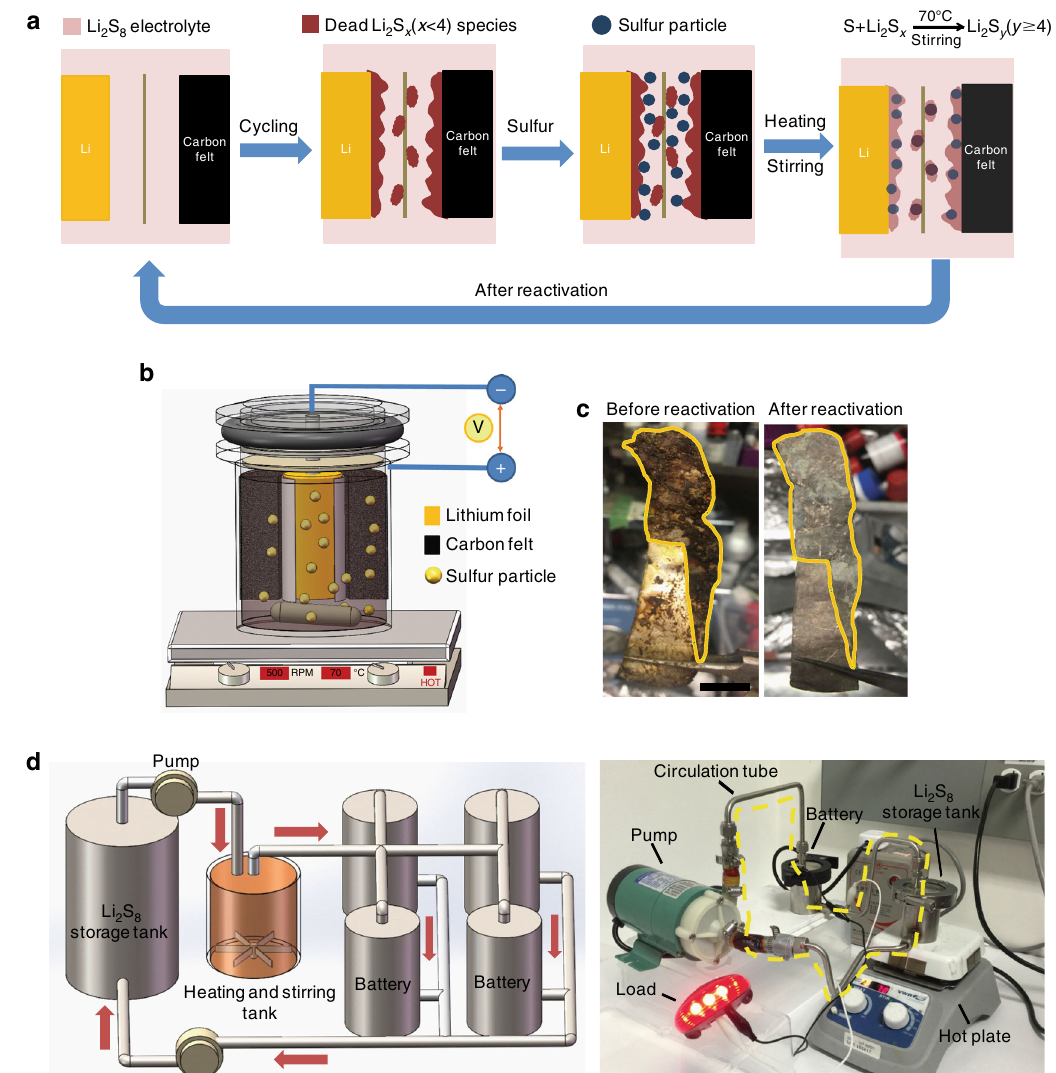
Fig. 1 Schematic and optical image of reactivation of LPS battery using stirring and heating method. a Schematic of the reactivation process by reaction of sulfur particles with dead sul fi de species under stirring and heating condition. b Design of LPS battery tank with reactivation function on a stirring and heating hot plate. (A magnetic stir bar was placed at the bottom of the battery tank for stirring and additional sulfur powder was placed on the bottom before sealing). c Optical image of lithium foil before and after reactivation (heating and stirring at 70 °C for 3 h). Dead sul fi de species are shown on the surface of lithium foil marked by the outlined yellow area (before reactivation, after 50 cycles). After reactivation, almost all of the dead sul fi de species disappeared. ( Scale bar , 2 cm) d Schematic drawing of LPS fl ow battery system for future grid energy storage (left). and optical image of LPS fl ow battery system (with the function of reactivation) demonstration based on above schematic drawing